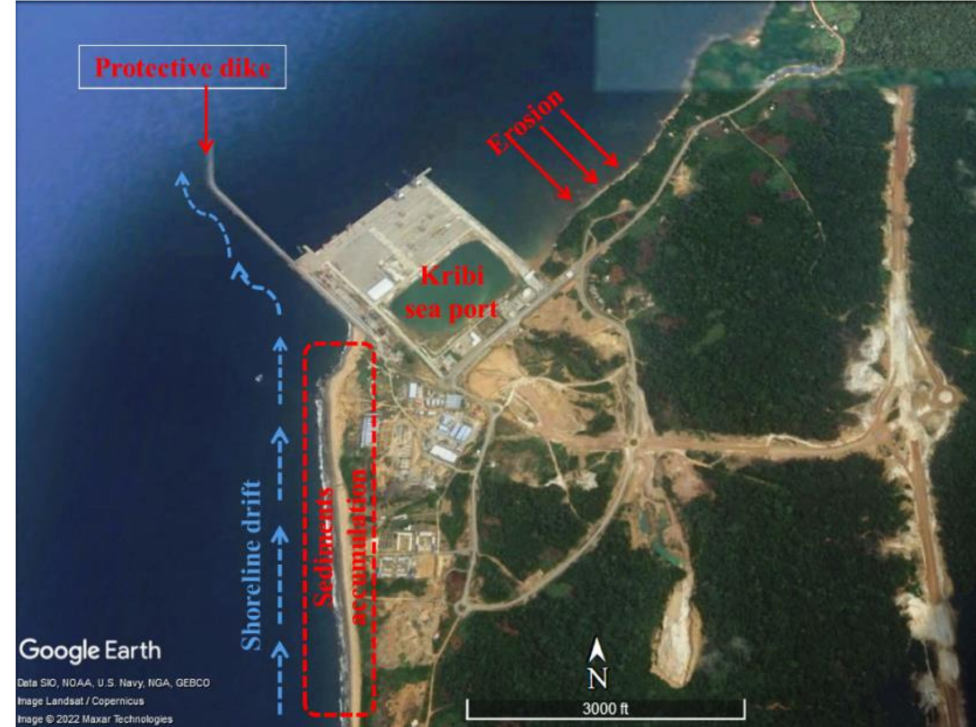
Figure 21. Google Earth aerial photo of the PAK in 2017 showing fattening south of the port and thinning to the north, where the beach has disappeared, and the forest has begun to be attacked by waves at high tide. The littoral drift runs from south to north and is interrupted by the dyke, generating this situation.